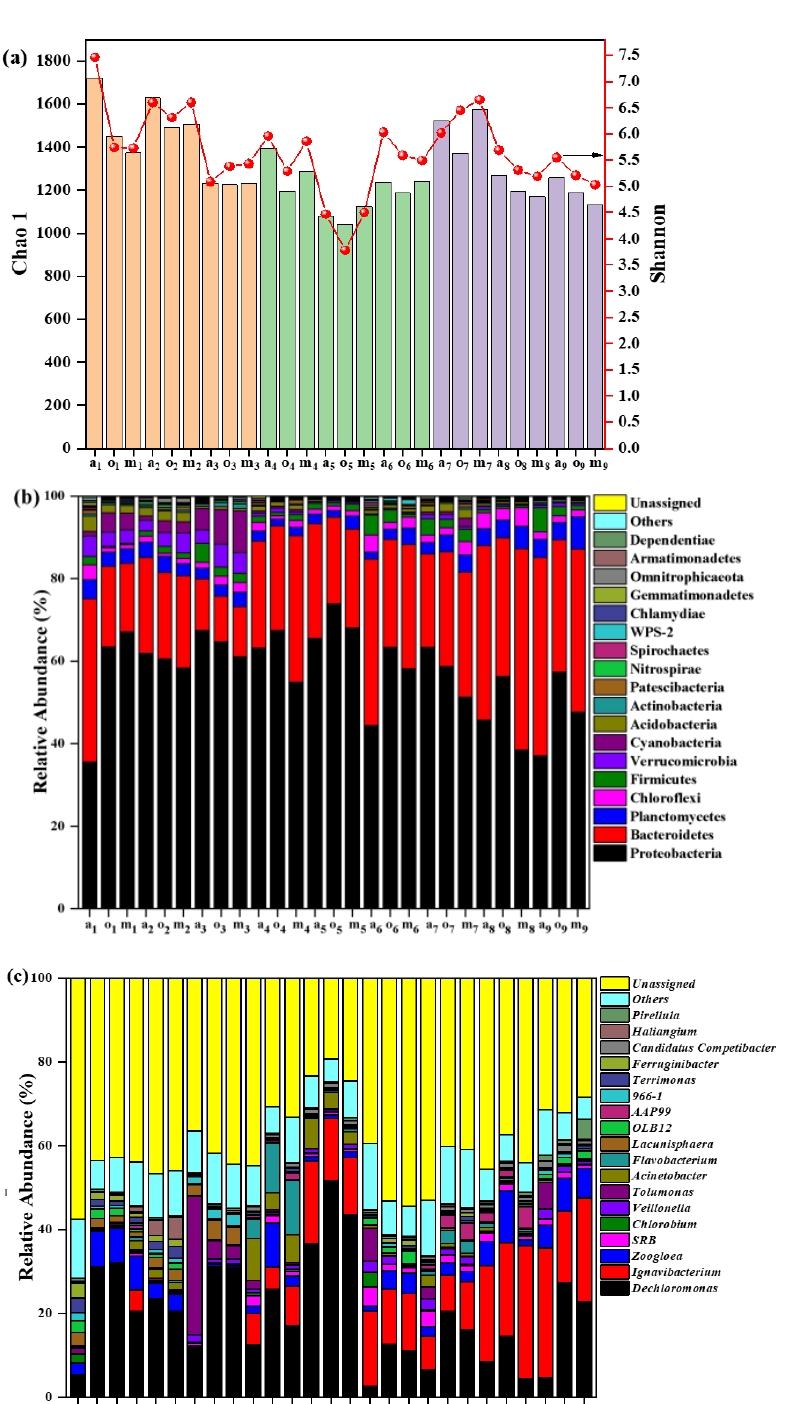
Figure 4. ( a ) Chao 1 and Shannon (red line) indexes, relative abundance of dominant species at ( b ) the phylum and ( c ) the genus level. (Here, a, o, and m are on behalf of the anoxic, oxic, and membrane tank, respectively. In detail, a 1 – m 3 , a 4 – m 6 , and a 7 – m 9 mean the samples of MBR control , AOA S150 , and AOA S300 . The subscript number denotes the sampling time. For example, 1, 4, and 7 represent the initial stage of MBR control , AOA S150 , and AOA S300 ; 2, 5, and 8 represent the middle stage; and 3, 6, and 9 represent the final stage of MBR control , AOA S150 , and AOA S300 , respectively). To identify the possible correlation among different genera in the three bioreactors, Furthermore, AOAS 150 and AOA S300 had higher abundances of Ignavibacterium compared a network analysis was performed by using Gephi (v 0.9.2) [63], with a Pearson’s corre- with the MBR control (lower than 0.1% on day 90). The relative abundance of Ignavibacterium lation coefficient ρ > 0. 6 and significance p < 0.01 (Supplementary Figure S7). Nodes with in the AOAS 150 bioreactor varied from 5.29 to 9.41% (day 1) and from 13.06 to identical colors were classified into the same module, and the node size was determined by the relative abundance of the genus. The red and green connection lines represent positive and negative correlations, respectively [64]. As shown in Supplementary Figure S7, there were more positive correlations than negative correlations. The sulfate-reducing bacterium Desulfovibrio was positively related with Chloroherpeton and Chlorobaculum , the green sulfur bacteria [65,66]. Desulfocapsa and Desulfomicrobium (SRB) had a positive cor- relation with the green sulfur bacterium Chloroherpeton , hydrolytic denitrifying bacterium Flavobacterium [13,67], and green sulfur bacterium Chlorobaculum , respectively. In addi- tion, Ignavibacterium , the sulfur autotrophic denitrification bacterium, correlated with fermentative bacterium Longilinea Anaerolinea [14,68] and green sulfur bacterium Chloro- baculum positively. Therefore, bacteria related to sulfur metabolism and hydrolytic fer- mentative bacteria interacted to promote the sludge reduction in the system.